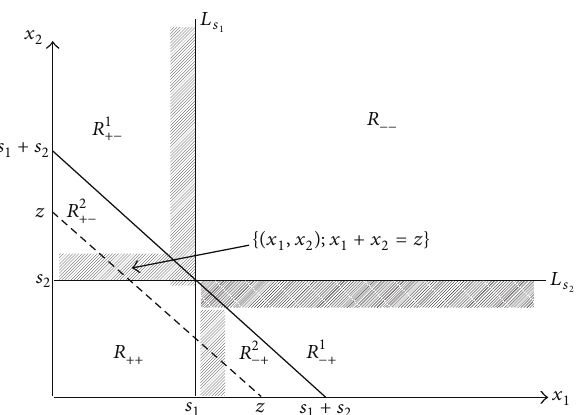
Figure 1: Domains separating function 𝑓(𝑥 1 ,𝑥 2 ) ( 𝑠 1 and 𝑠 2 are